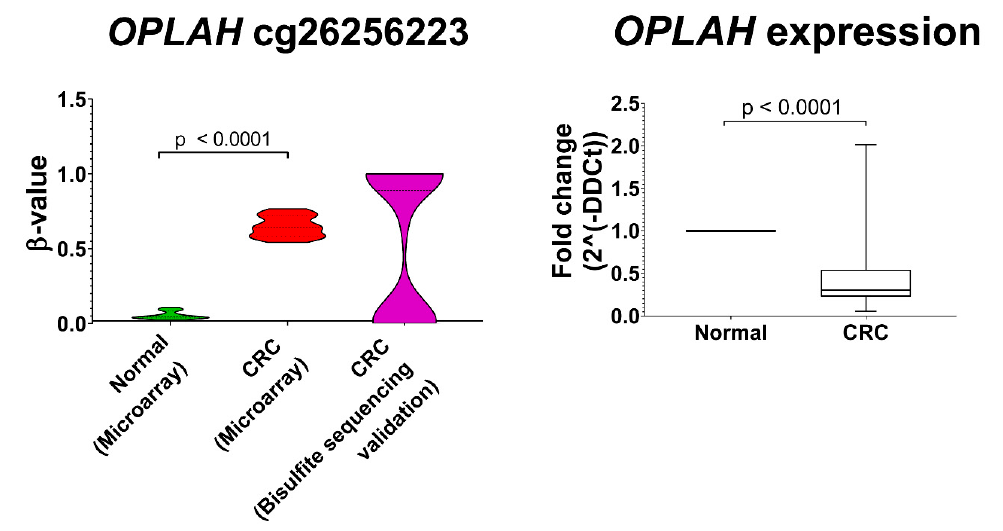
Figure 6. Significant OPLAH downregulation was observed in the cancer tissues (CRC) compared to the normal colon. OPLAH cg26256223 hypermethylation was also validated in our validation samples.